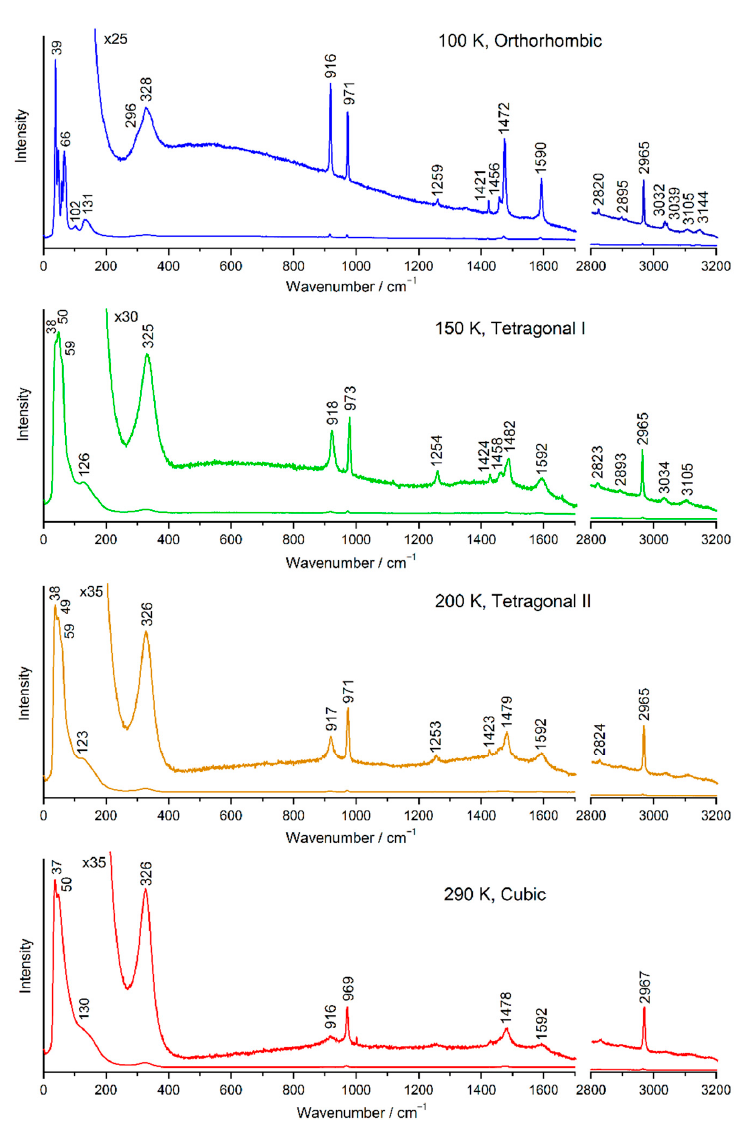
Figure 1. Raman spectra of an MAPbBr 3 pellet; excitation wavelength: 633 nm.